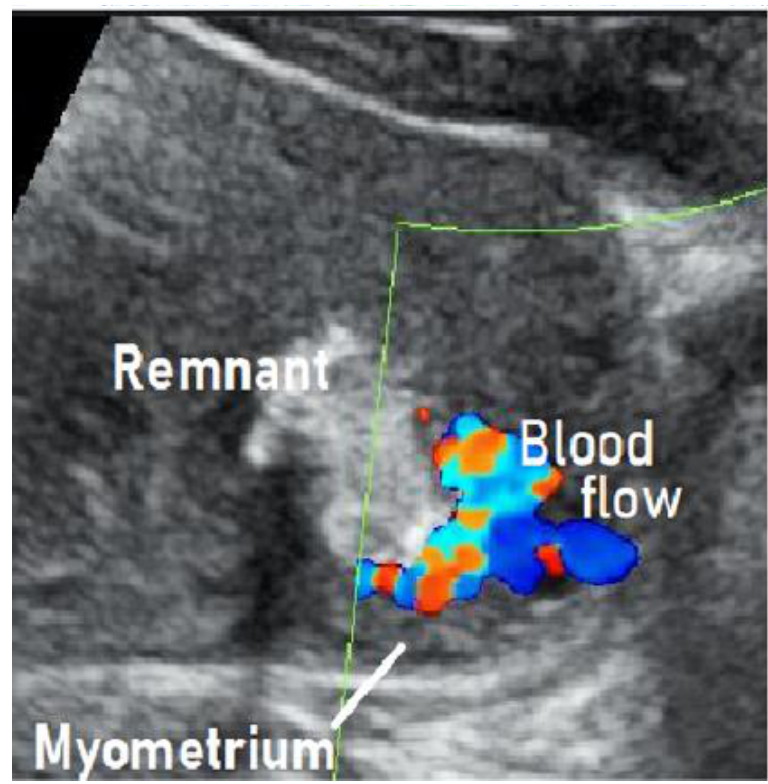
Figure 1. Findings of color Doppler ultrasound: Hypervascular appearance with turbulent flow. The hypervascularity was limited to the point of contact between the remnant and the myometrium, and there was no pulsatile perfusion in the remnant itself.